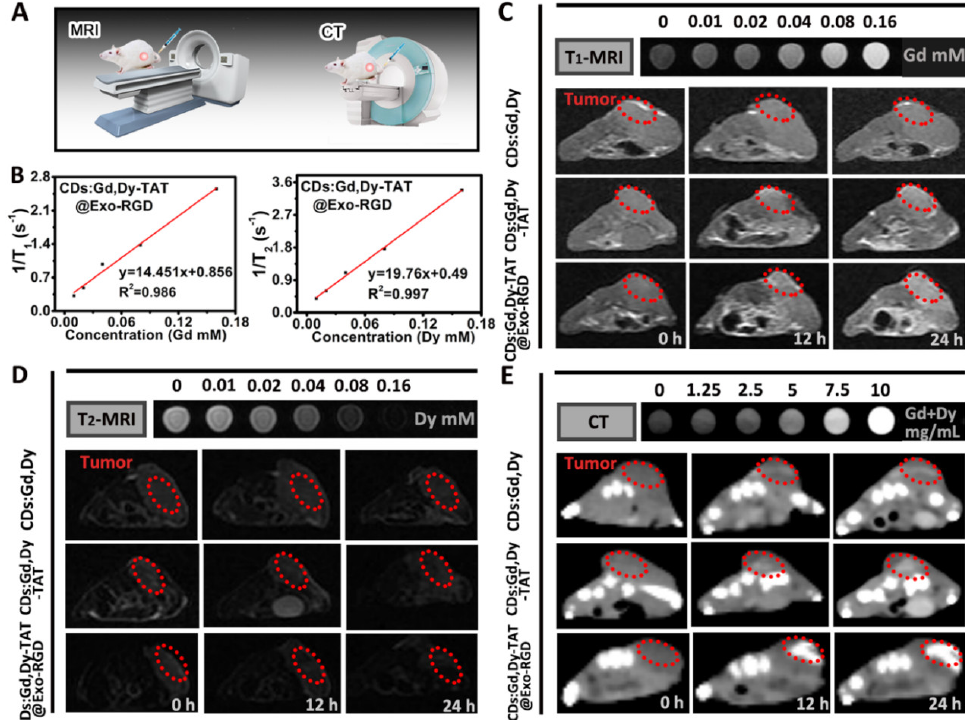
Figure 5. T 1 -MRI, T 2 -MRI and CT imaging performance of CDs:Gd,Dy-TAT@Exo-RGD. ( A ) The schematic illustration of MRI and CT imaging. ( B ) r 1 / r 2 relaxivity values of CDs:Gd,Dy-TAT@Exo- RGD. In vivo T 1 -MRI ( C ), T 2 -MRI ( D ) and CT imaging ( E ) of tumor-bearing mice before and after intravenous injection of CDs:Gd,Dy, CDs:Gd,Dy-TAT or CDs:Gd,Dy-TAT@Exo-RGD for 12 h and 24 h; the red dots circle the tumor site and the images at the top are the corresponding phantom images.